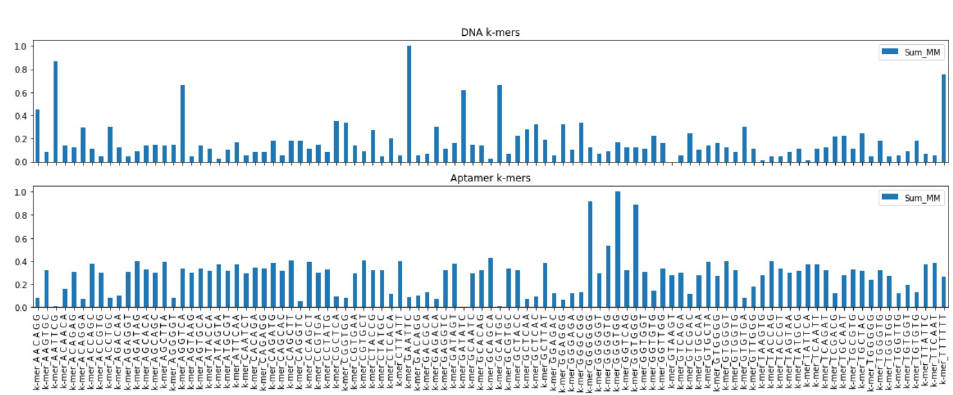
Fig 4. Bars plot of selected 6-mers and their normalized distribution. Top graph: distribution of chosen 6-mers in genomic DNA sequences. Bottom graph: distribution of chosen 6-mers in DNA aptamer sequences.